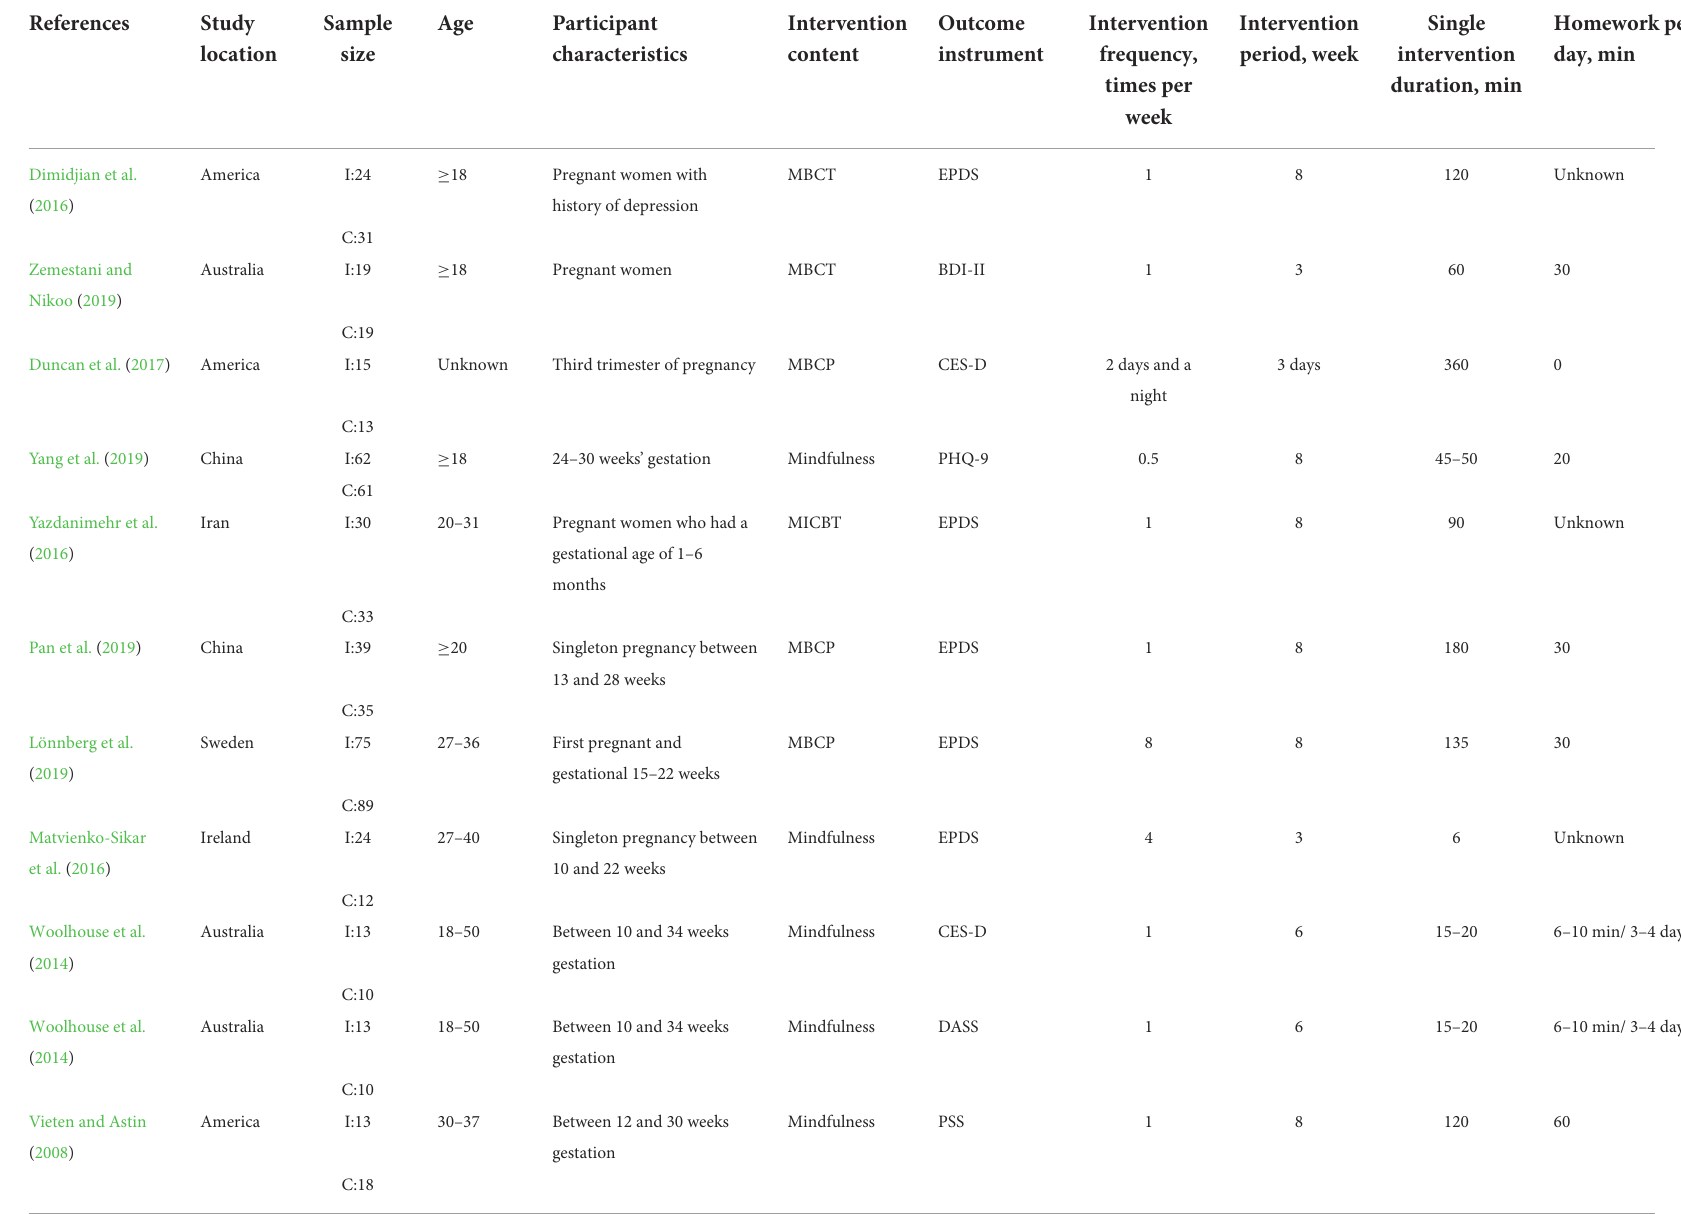
TABLE 1 Characteristics of the included